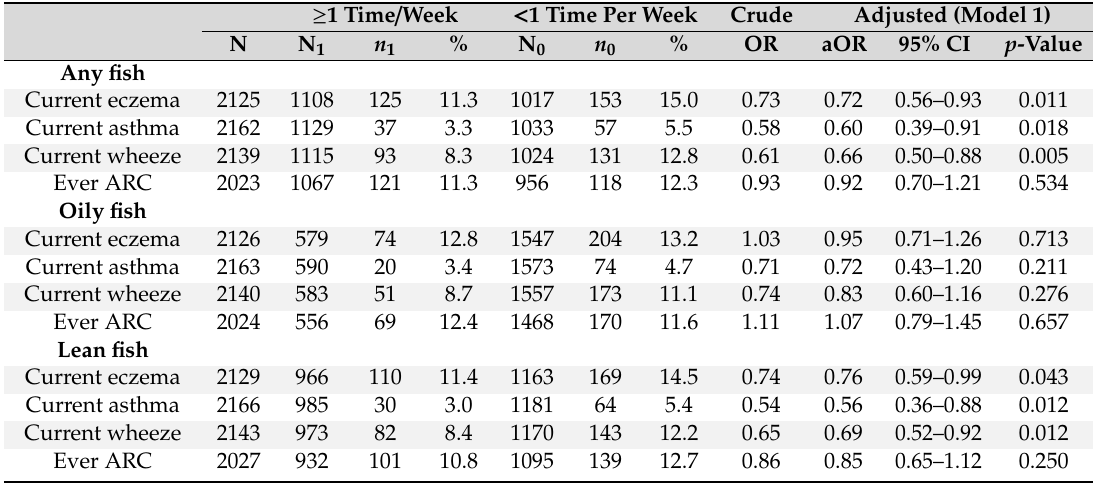
Table 2. Association between infant dietary fish at one year and allergic disease / symptoms at six years: Crude and adjusted models.